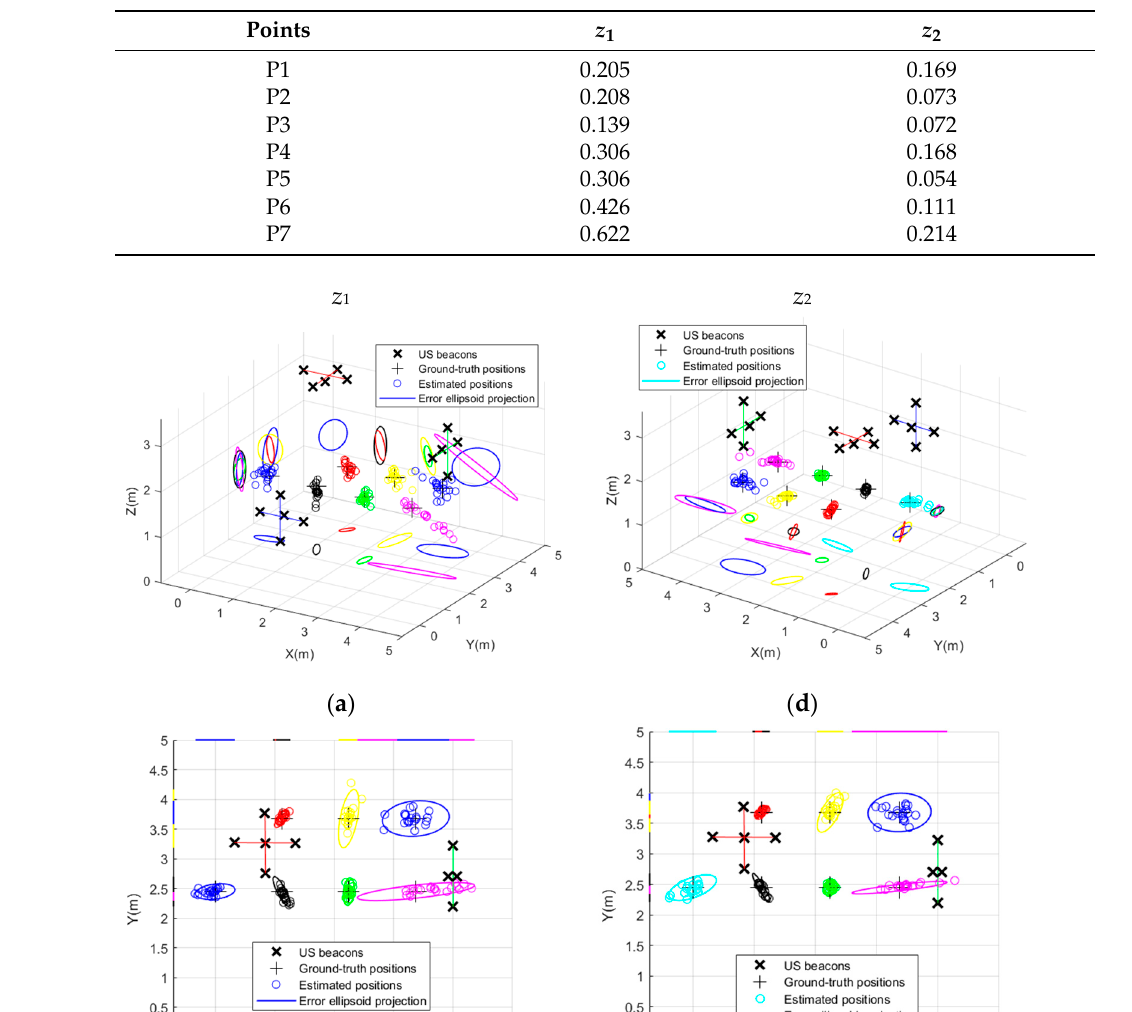
Table 6. Positioning error (m) for points P1–P7 in 90% of cases after an AKF.